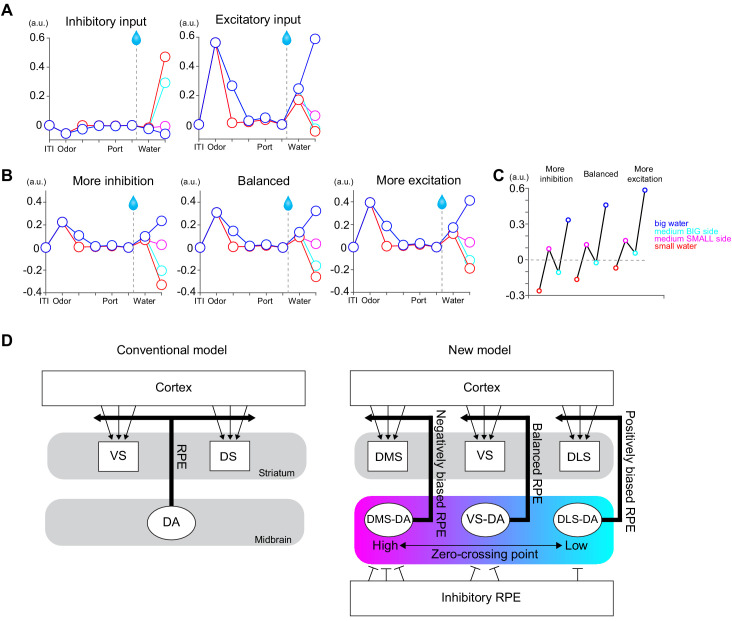
A potential mechanism of different zero-crossing points in dopamine neurons.(A) A simplified model with only two inputs, one is inhibitory, and the other is excitatory, both of which encode TD errors but send information to the postsynaptic neurons mainly with excitation (1/10 with inhibition). (B) TD errors in postsynaptic neurons with different ratios of presynaptic inputs, balanced (1:1), more inhibition (two times more inhibitory inputs) and more excitatory (half of inhibitory inputs). (C) Net responses to water in these three postsynaptic neurons. (D) Left, conventional models such as actor-critic models assume the same TD errors to be broadcasted throughout the striatum. Right, we propose that the striatal subareas receive slightly different TD errors with different zero-crossing points. One of potential mechanisms is different ratios of presynaptic inputs. Arbitrary unit (a.u.) was determined by value of standard reward as 1 (see Materials and methods).